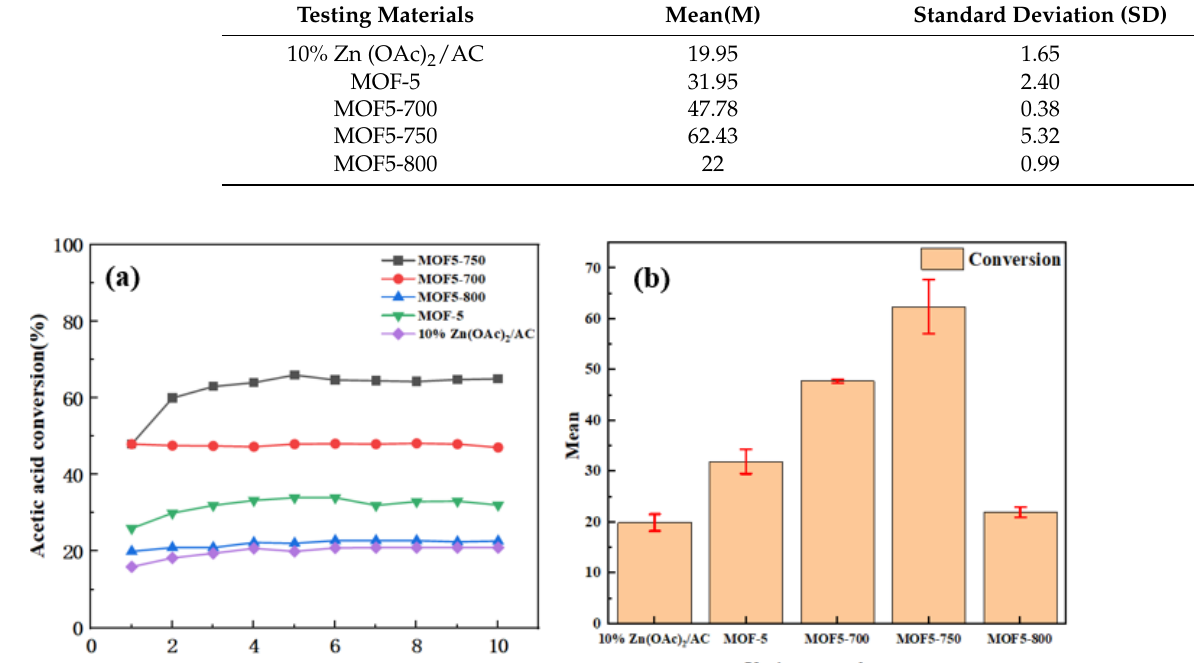
Figure 9. SEM of MOF-5 obtained with different organic ligands H 2 BDC ( a ), H 2 BDC(NH 2 ) ( b ), H 2 BDC(NO 2 ) ( c ).